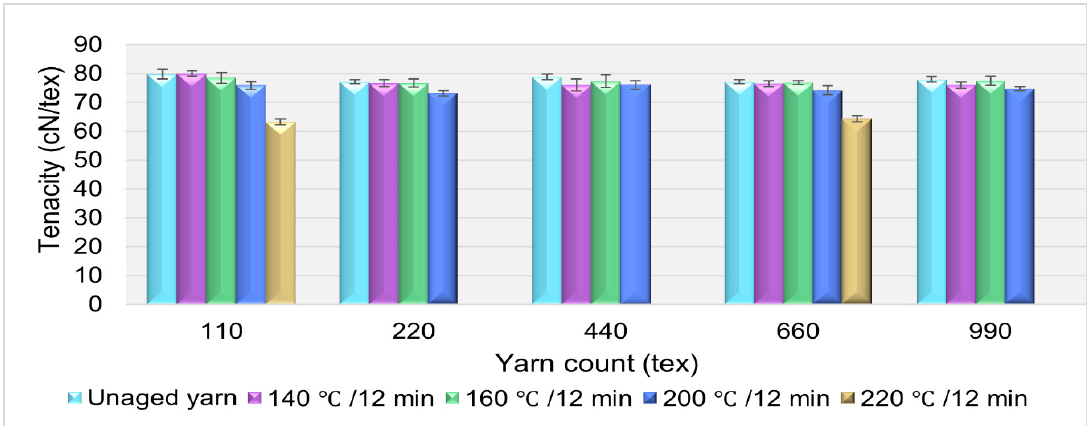
Figure 5. Effect of aging temperature on the tenacity of HT polyester yarn.